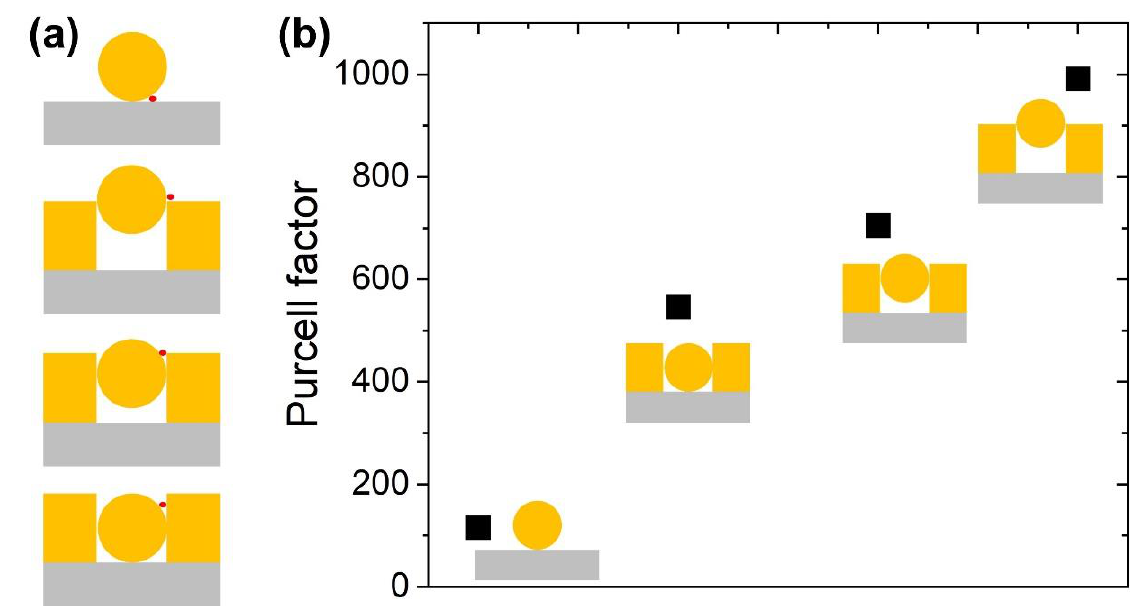
Figure 5. ( a ) Schematic position of an emitter (solid red color dot) placed close to “hot-spot” or EF max region and extracted Purcell factor ( b ).